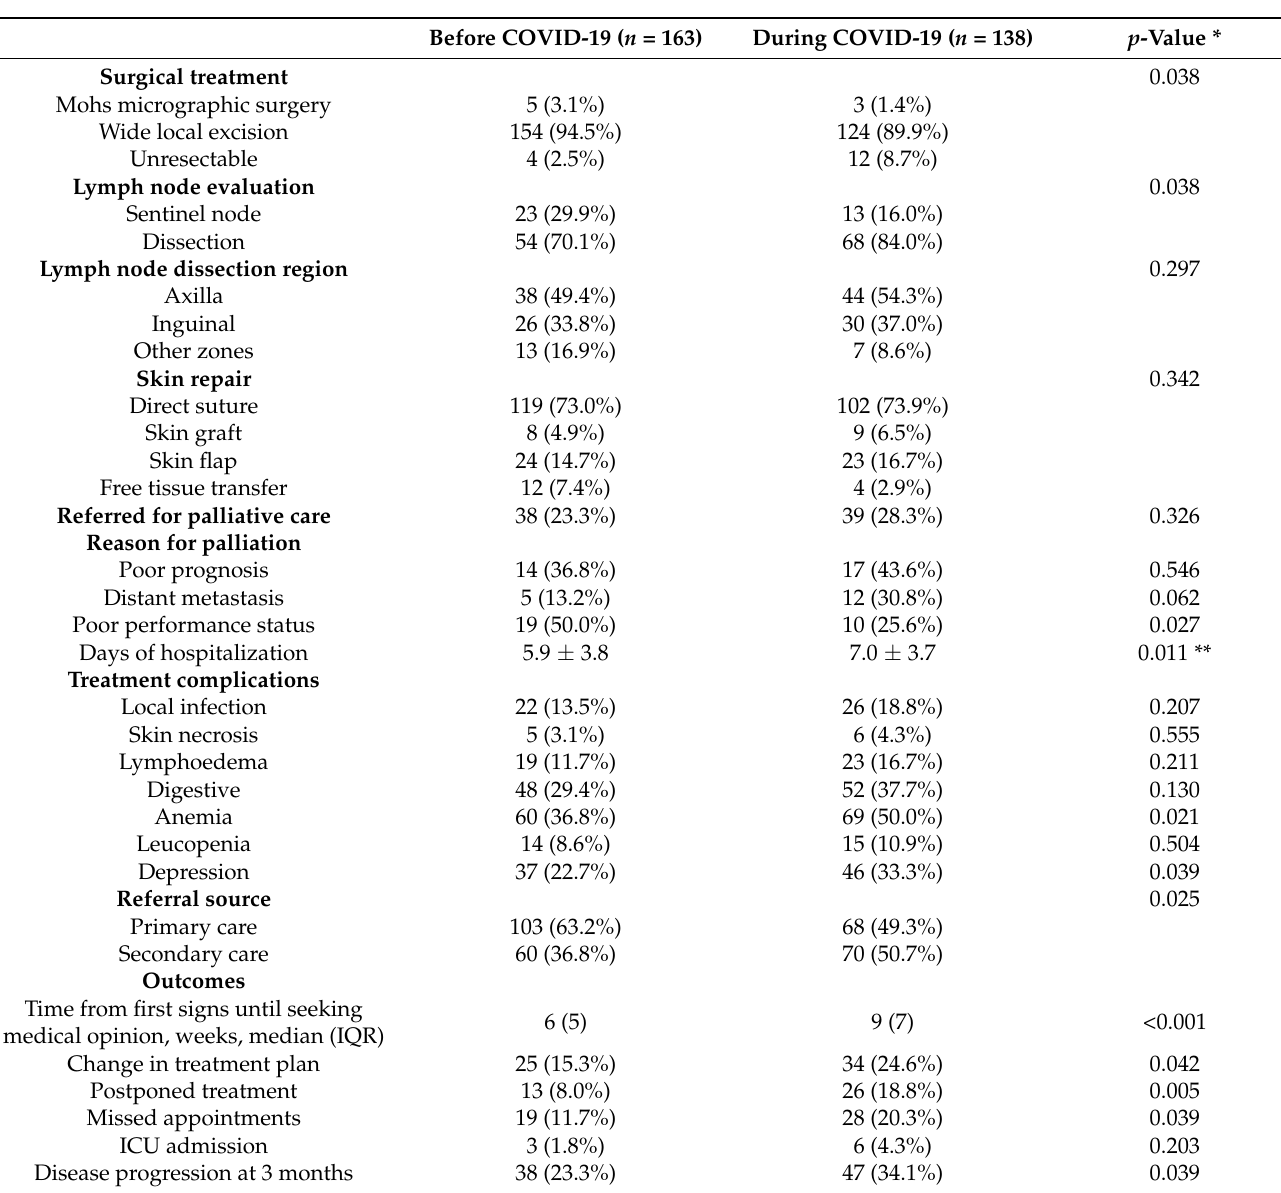
Table 3. Outcomes and interventions of patients with malignant melanoma before and during the COVID-19 pandemic. Before COVID-19 ( n = 163) During COVID-19 ( n = 138) p -Value * Surgical treatment